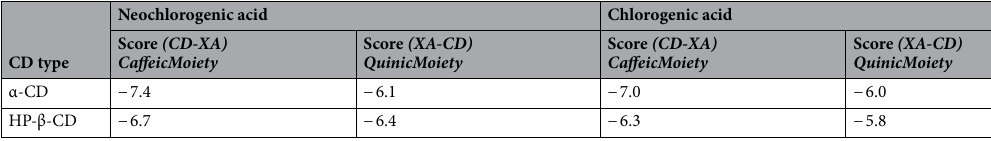
Table 2. Results for molecular docking with the two best CDs classified by the encapsulated moiety of the ligand.